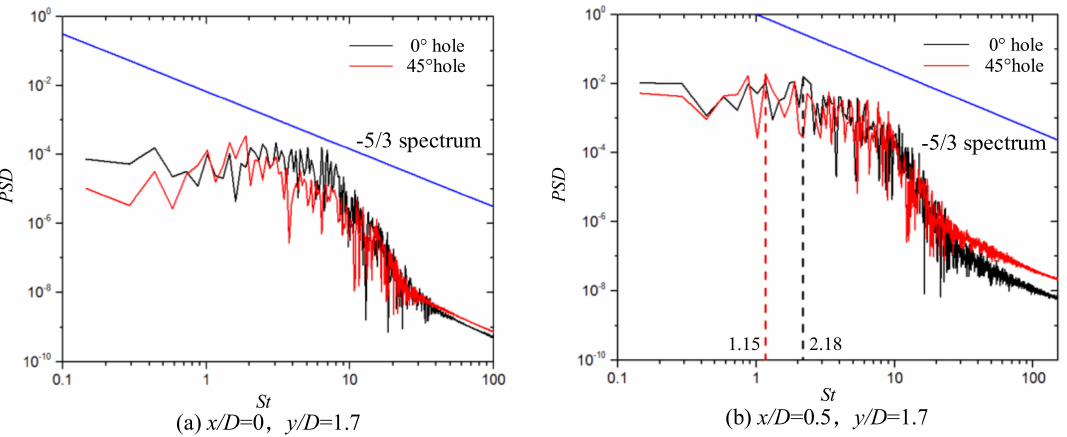
Figure 11. Power spectral density of the axial fluctuating velocity in jet